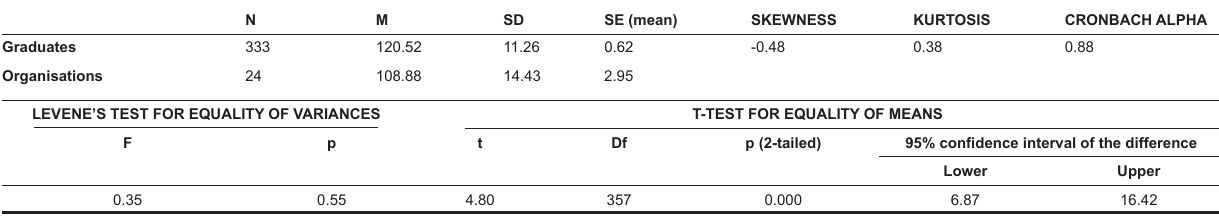
TABLE 3 Scale descriptives for the 28-item Work Readiness Skills Scale and comparison between means of graduates and organisations